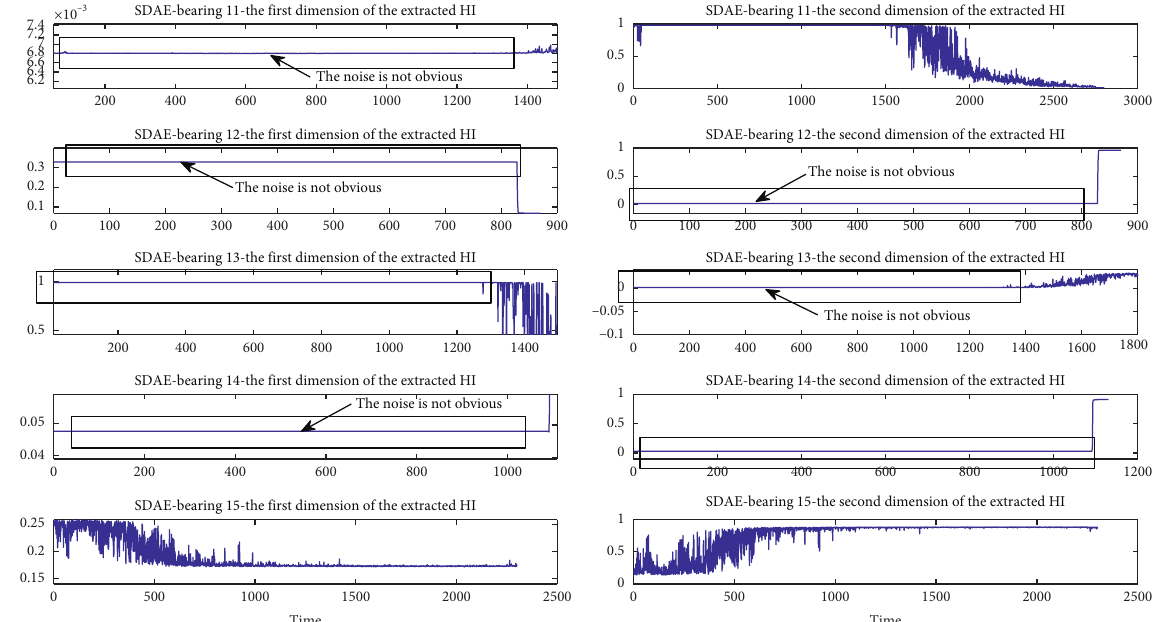
Figure 11: Extracted two-dimensional degradation features for bearings 11–15 through the final hidden layer by using the the horizontal axis. However, in Figure 14(c), many data points are scattered because there is massive noise in Figure 8 when the SAE is used. Thus, the feature extraction of the SDAE is superior to that of the SAE.